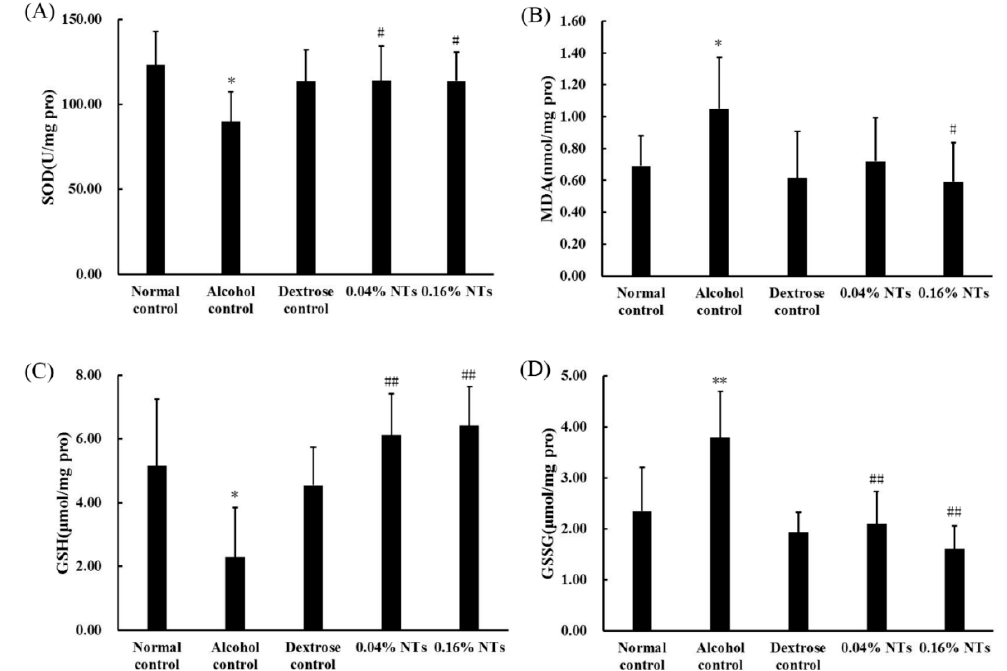
Figure 2. Effects of nucleotides (NTs) on oxidative stress in liver tissues of rats. ( A ) Superoxide dismutase (SOD) activity; ( B ) malondialdehyde (MDA); ( C ) reduced glutathione (GSH); and ( D ) oxidized glutathione (GSSG) levels in liver tissues of rats. Values were expressed as the mean ± standard deviation of ten rats per group. Mean values were significantly different from those of the dextrose control group: * p < 0.05; ** p < 0.01. Mean values were significantly different from those of the alcohol control group: # p < 0.05; ## p < 0.01.